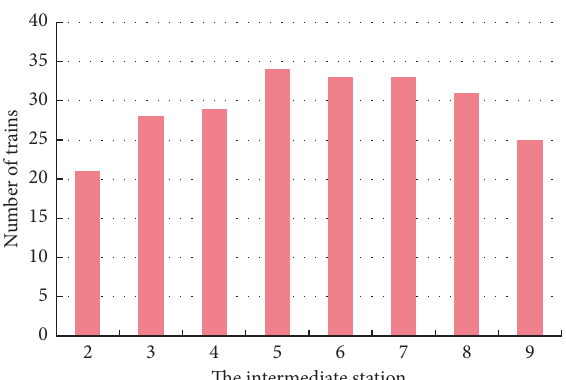
Figure 14: Number of trains stopping at intermediate